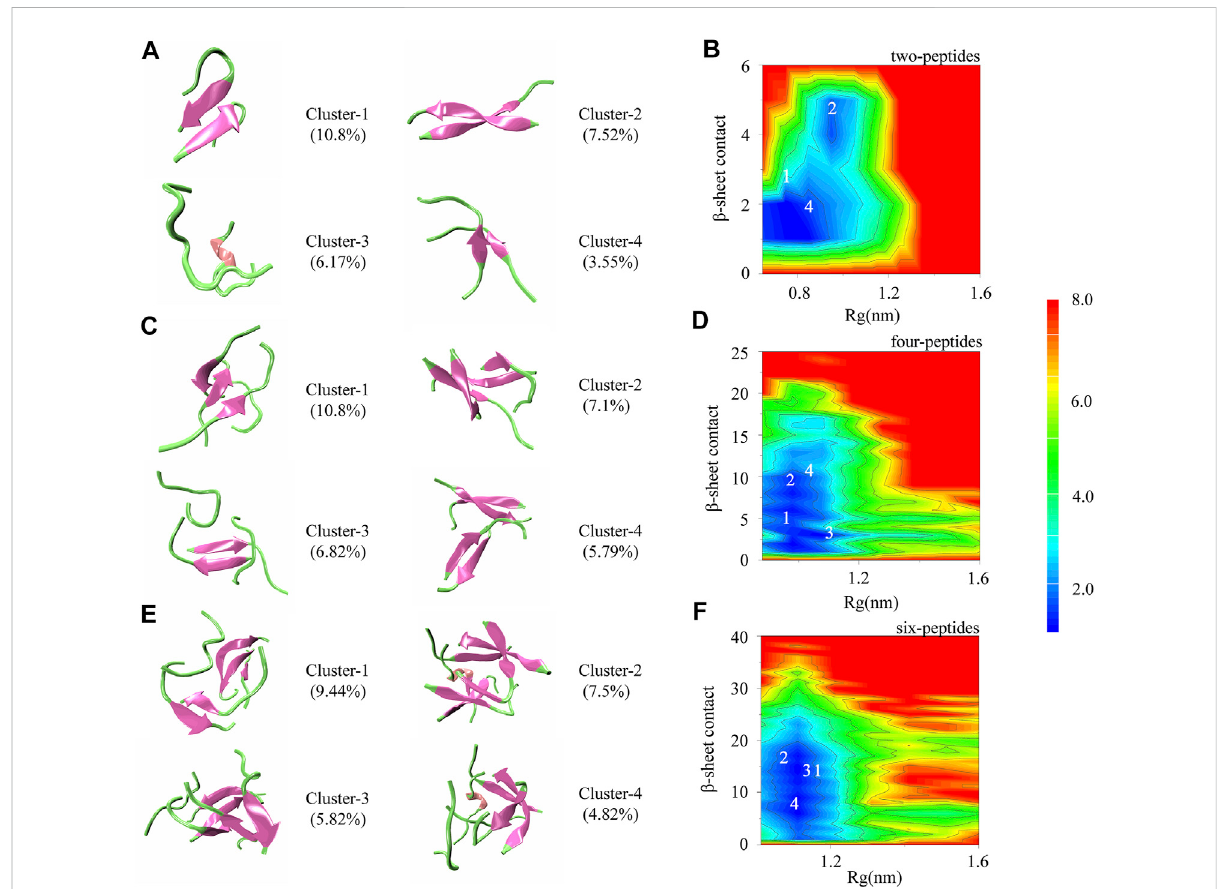
FIGURE 4 Cluster structure and conformational free energy landscape of TTR (105 – 115) simulation. Representative conformations of the top four most- populated clustersfortwo- (A) ,four- (C) andsix- (E) peptides. (B,D,F) The2Dpotentialmeanforce(PMF) asafunctionofradiusofgyration(Rg)and β - Sheet contact for two-, four-, and